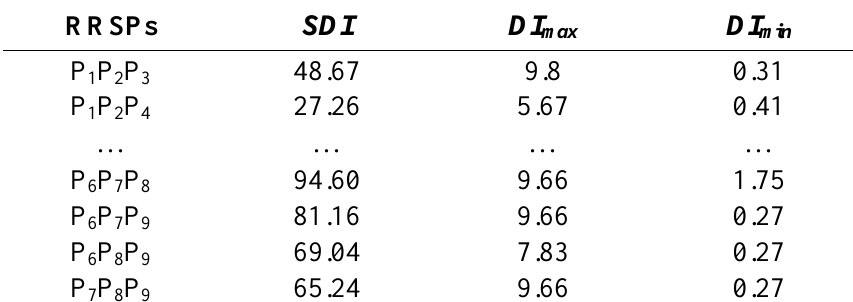
Table 2. DI s of P